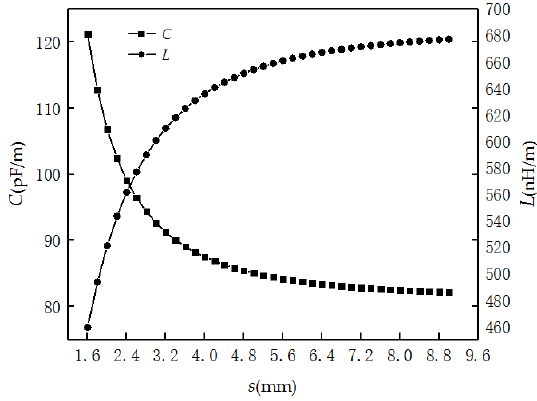
Figure 5. The calculated distribution capacitance C and inductance L of 22AWG PHSC.